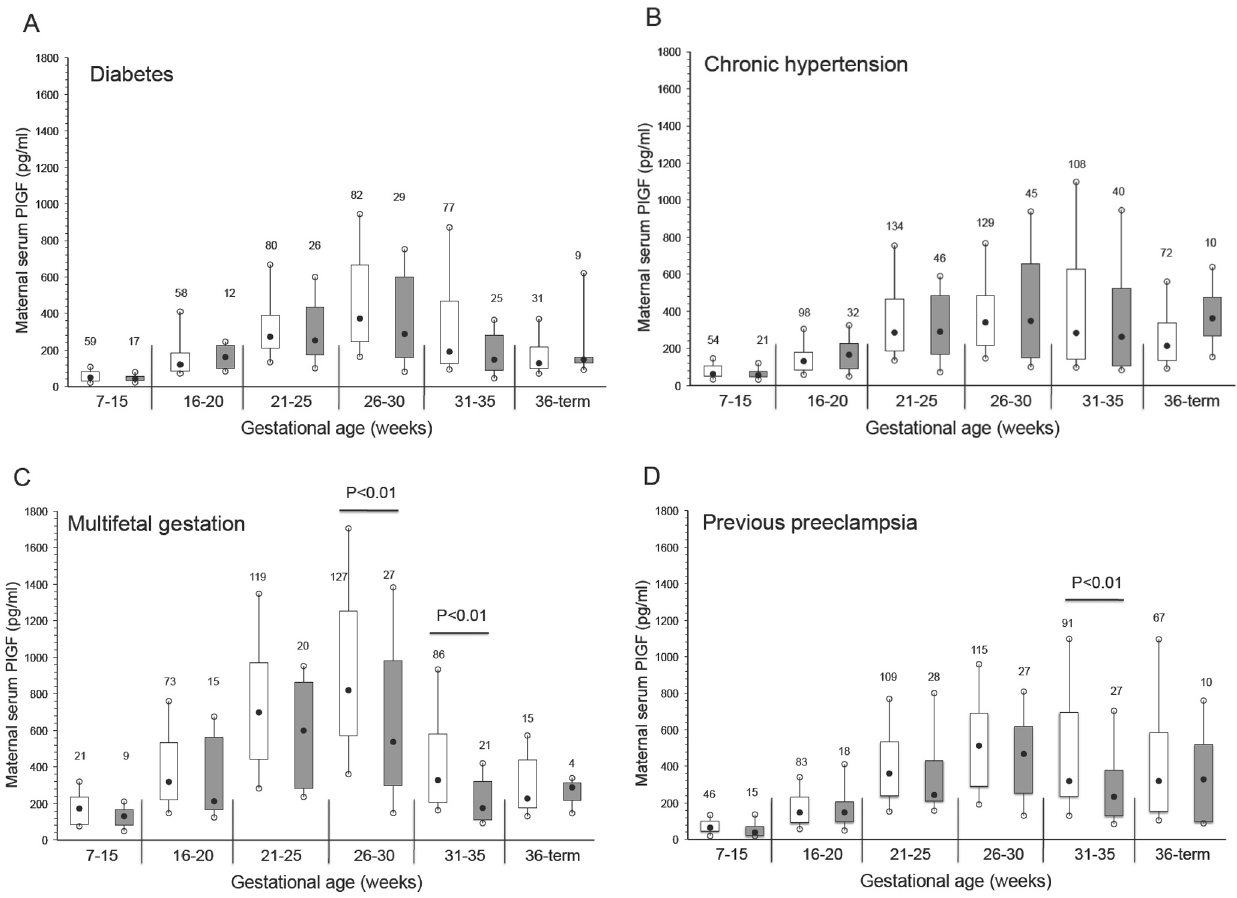
Figure 3. Maternal serum PlGF across gestation in women with pre-existing diabetes (A), chronic hypertension (B), multifetal gestation (C), and previous preeclampsia (D). Open boxes are controls and shaded boxes are subjects who developed preeclampsia. The number above each box indicates the number of samples. The filled black circles are the median, the open circles are the 90th and 10th percentiles, and the top and bottom lines of the box are the 75 th and 25 th percentiles of the data for each group. Statistical significance is indicated by p values.